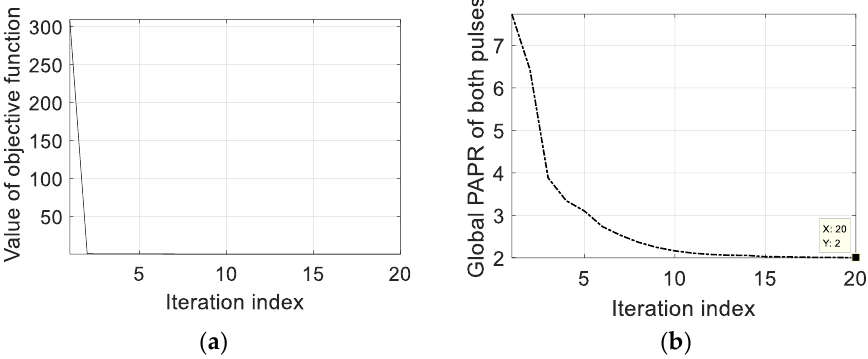
Figure 9. The convergence performance of POADMM and the variation of the global PAPR in the case of suppressing RDJ. ( a ) The convergence performance of the objective function using POADMM in the case of resisting RDJ. ( b ) The variation of the global PAPR in the case of resisting RDJ. The simulation parameters of resisting the JRVDJ are listed in Table 3, and the expression form of the target or jamming information is denoted by (the normalized delay, the normalized Doppler frequency). For example, the information surrounded by parenthesis of the target, (0.3, 0.36), means that the normalized delay and the normalized Doppler frequency are 0.3 and 0.36, respectively. The effect of dragging the targets in the Range–Doppler domain is simulated in Figure 10. The ECM effect can disable the sensing function of the radar. To disperse the jamming energy of the peaks, the PCSs of all the OFDM pulses in a CPI can be generated randomly. As shown in Figure 11, the level of the